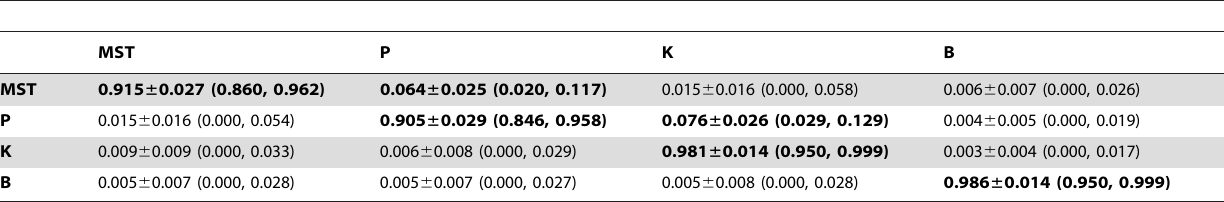
Table 5. Cluster-wise contemporary migration rates, m , showing means ( 6 standard deviation) of the posterior distributions along with the 95% confidence intervals in parentheses.